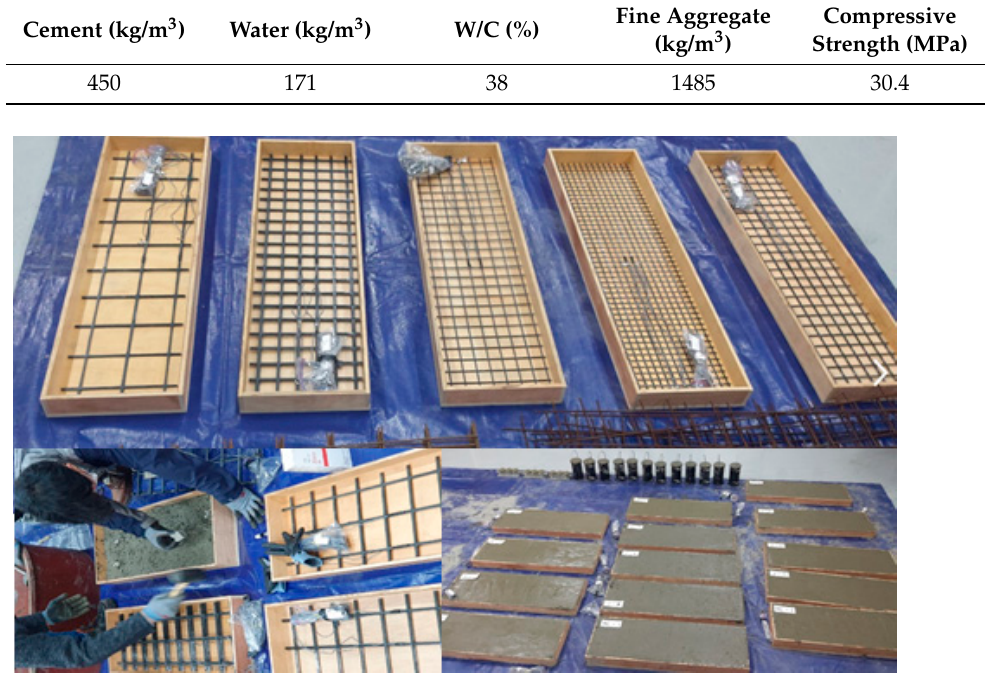
Table 3. Mix design and compressive strength of mortar.